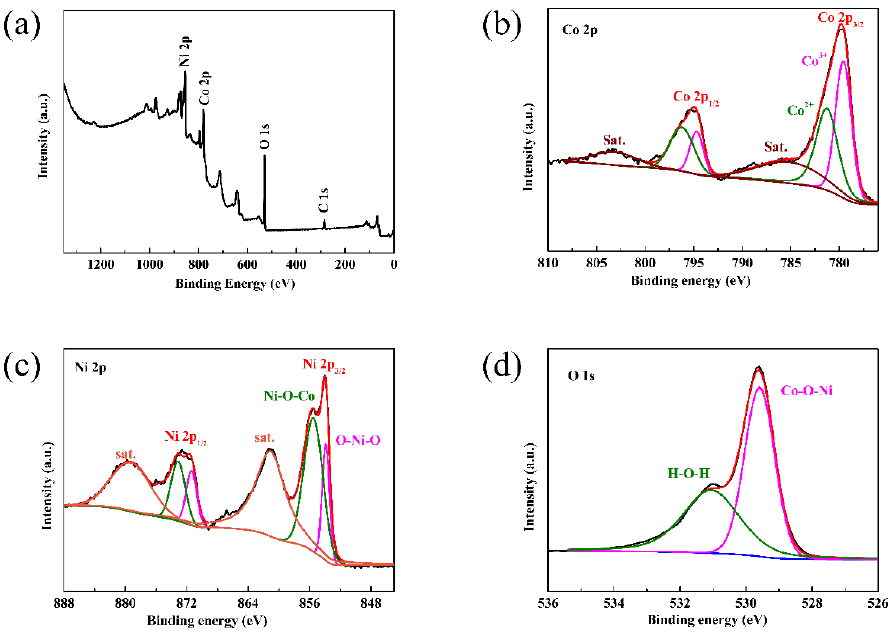
Figure 5. ( a ) Survey spectrum, ( b ) Co 2p, ( c ) Ni 2p and ( d ) O 1s for CoNiO 2 of XPS spectra.